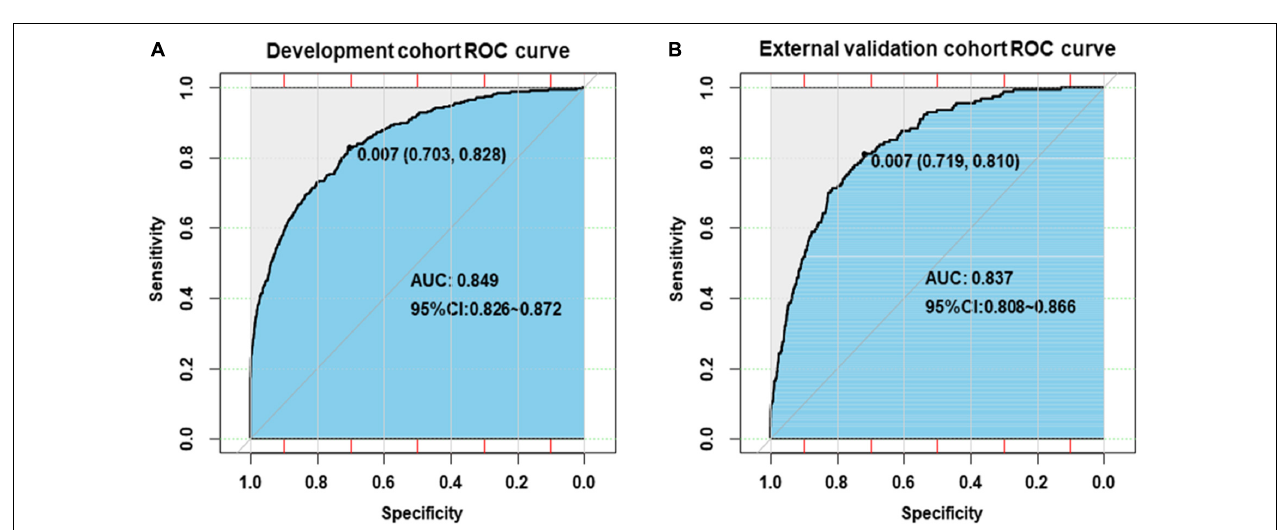
FIGURE 4 | Receiver-operating-characteristic curves for the prediction of congenital heart disease by nomogram in the development cohort (A) and the external validation cohort (B)